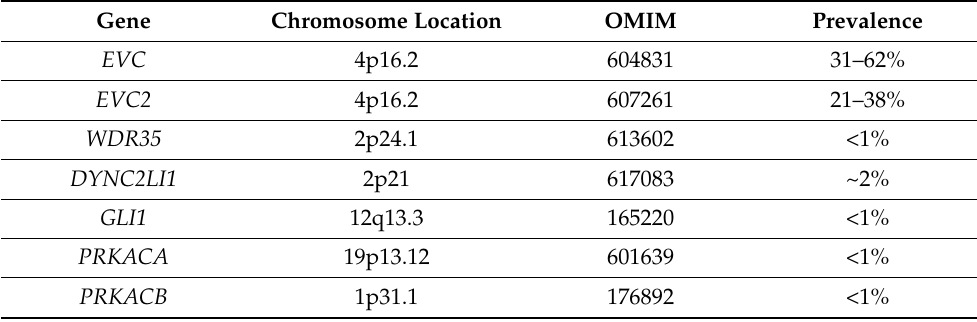
Table 1. Genetic heterogeneity of Ellis–van Creveld